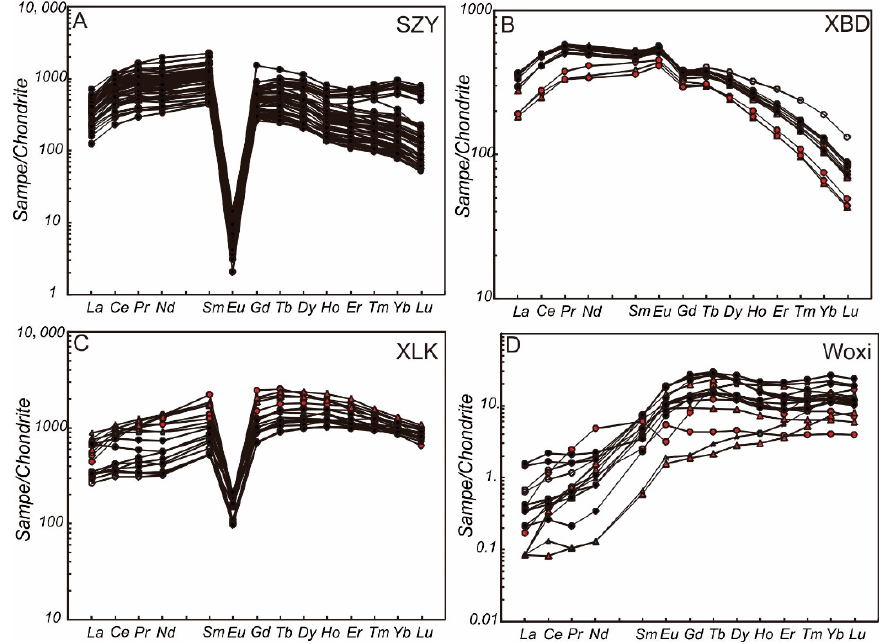
Figure 8. Chondrite-normalized REE patters of scheelites from ( A ) the Shizhuyuan W-Sn-Bi-Mo deposit, ( B ) the Xuebaoding W-Sn-Be deposit, ( C ) the Xingluokeng tungsten deposit and ( D ) the Woxi Au-Sb-tungsten deposit. Chondrite values are from Sun and McDonough [39].